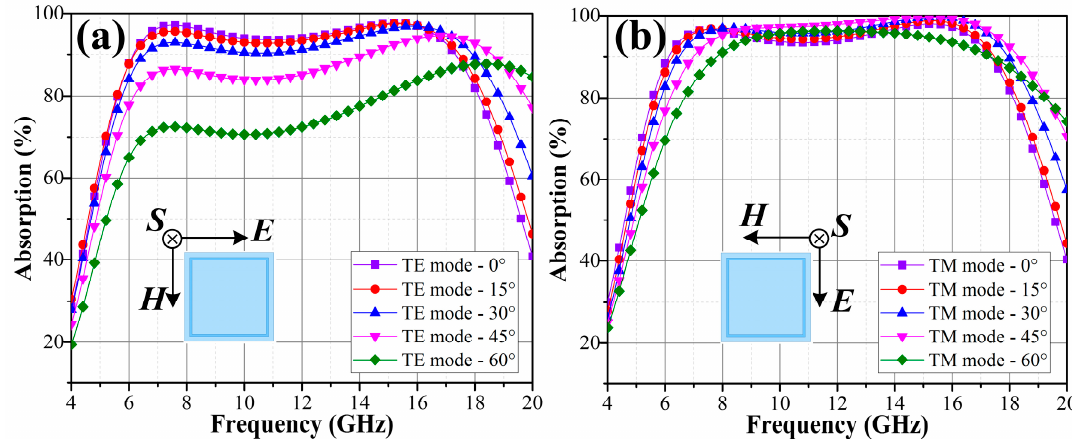
Figure 9. Simulated angular dependence of absorption performances of the OTMMA under different polarized incident waves: ( a ) TE and ( b ) TM waves.